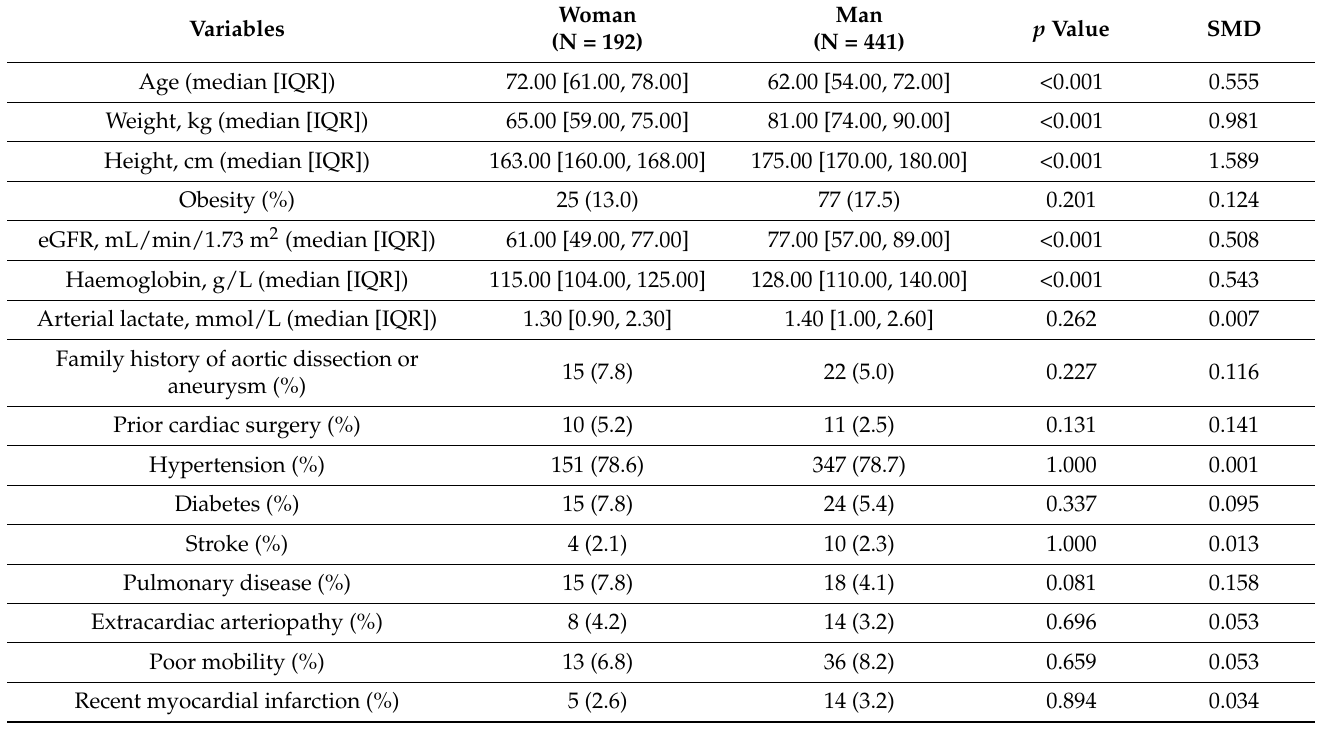
Table 1. Preoperative clinical and operative characteristics of the women and men